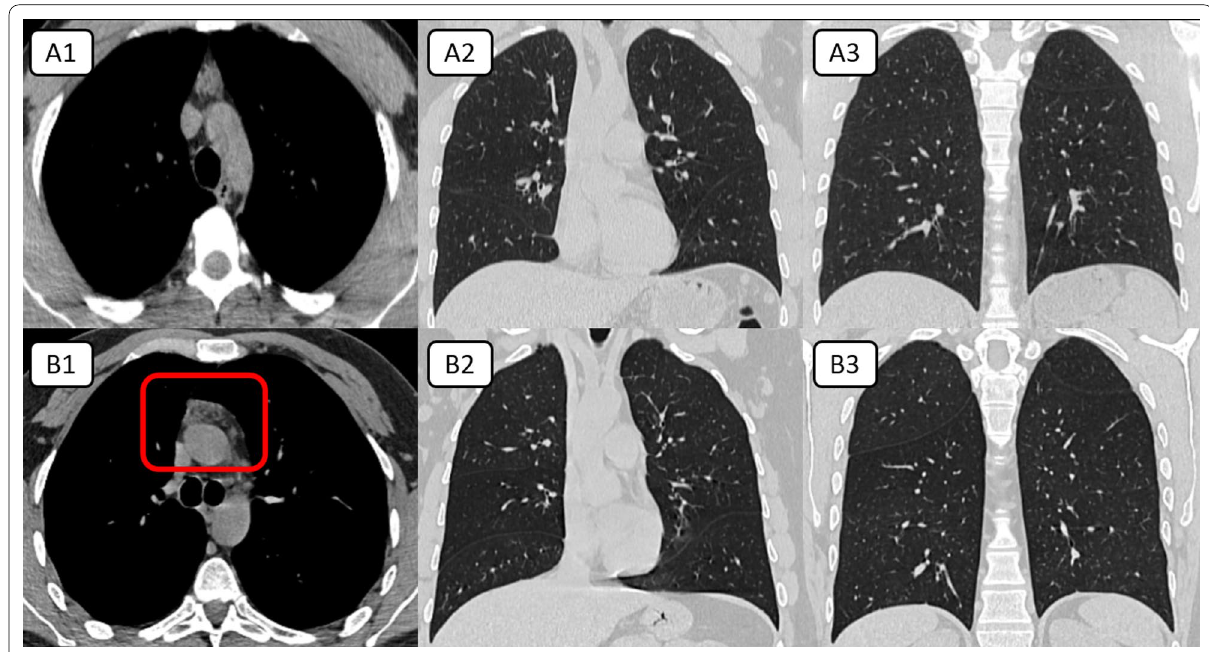
Fig. 7 Two COVID‑19 patients proved with PCR test results without lung involvement: ( A ) 31-year-old male patient complained from fever and cough for two days; [A1]: Axial mediastinal window CT showing solid soft tissue replacement of the thymic gland (grade 0). [A2-3]: Axial lung window CT cuts at the level of the cardiac silhouette and para-vertebral planes show clear bilateral lung parenchyma. ( B ) A 33-year-old male patient complained of fever, cough, and chest pain for three days; [B1]: Axial mediastinal window CT showing a nodular pattern of the thymic gland (grade